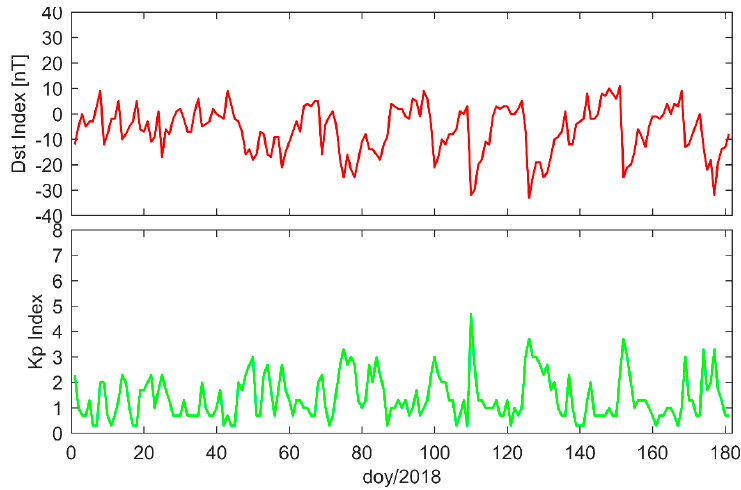
Figure 14. The disturbance storm time (Dst) and Kp indices during the period from 1 January 2018 to